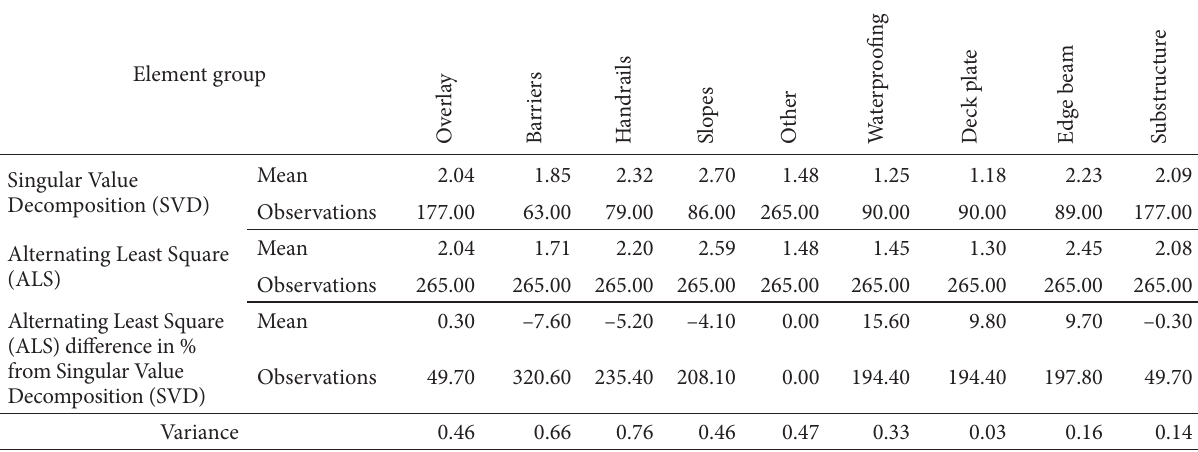
Table 4. Comparisonof different PCA algorithm results